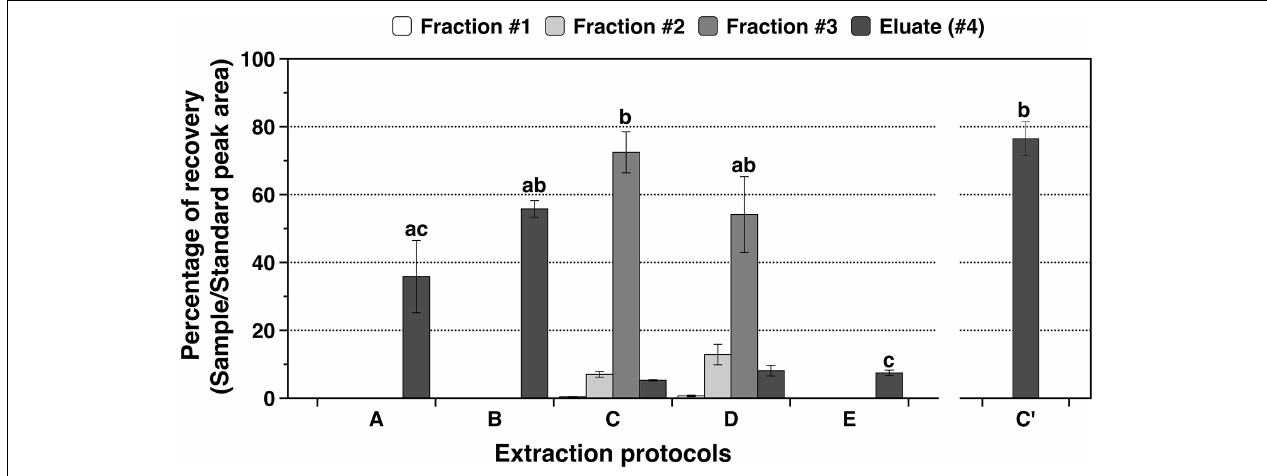
FIGURE 4 | Recovery percentages for all the fractions (#1, #2, and #3) and eluates (#4) of the five extractions protocols (A, B, C, D, and E) and new method (C’) on NRVC980385 leaves. Methods detail for A to E can be seen on Figure 1 . Columns correspond to mean ± SEM of 4 replicates for methods A to E whereas mean ± SEM of 6 replicates for method C’, letters above bars indicate significant differences between varieties for each tissue analyzed (Tukey tests at p <